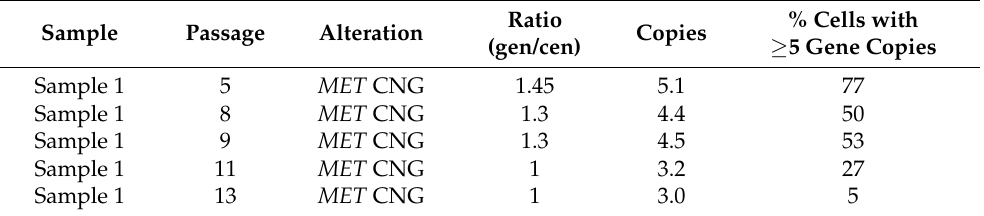
Table 3. Results of the detection of CNGs by FISH in primary cultures. Ratio refers to the number of copies of the corresponding gene per cell divided by the number of copies of the centromere where the gene is located ( MET /CEN7, EGFR /CEN7, and FGFR1 /CEN8, respectively). Copies refer to the average copy number of MET , EGFR , FGFR1, or MYC, respectively. % Cells refers to the percentage of cells carrying 5 or more copies of the corresponding gene. AC, adherent cells; FC, floating